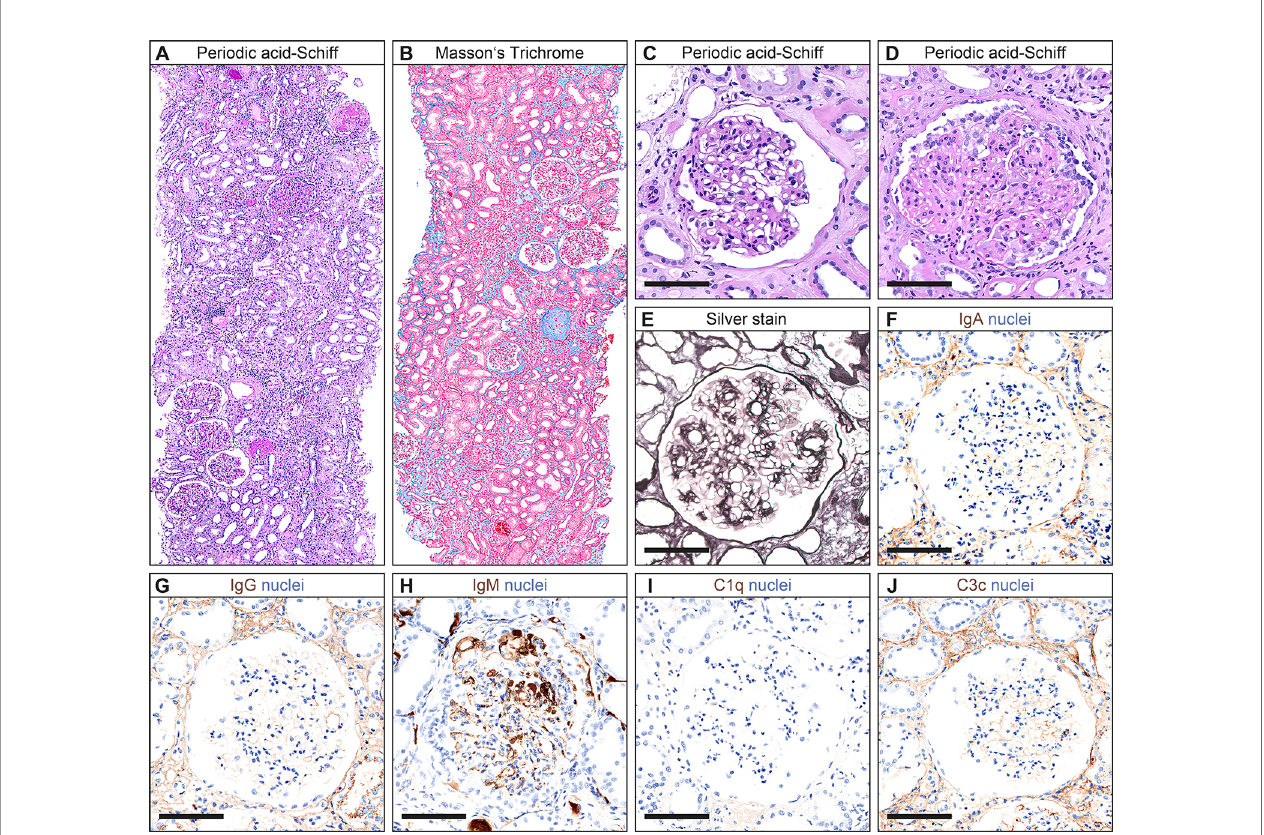
FIGURE 2 | Histopathological fi ndings. (A, B) Representative kidney sections stained with periodic acid-Schiff and Masson ’ s Trichrome showing acute tubular injury and mild interstitial fi brosis. (C) Glomeruli showed mild mesangial expansion according to Tervaert class IIa. (D) Notably, collapsing FSGS was present. (E) As shown by silver stain, no double contours of the basement membrane were detectable. (F – J) No subendothelial immune deposits (IgA, IgG, IgM, C1q, and C3c) were detectable, while IgM was entrapped in damaged glomerular capillaries. Scale bars: 100 m m. Abbreviations: C1q, complement component 1q; C3c, complement factor 3 conversion product; FSGS, focal segmental glomerulosclerosis; IgA, immunoglobulin A; IgG, immunoglobulin